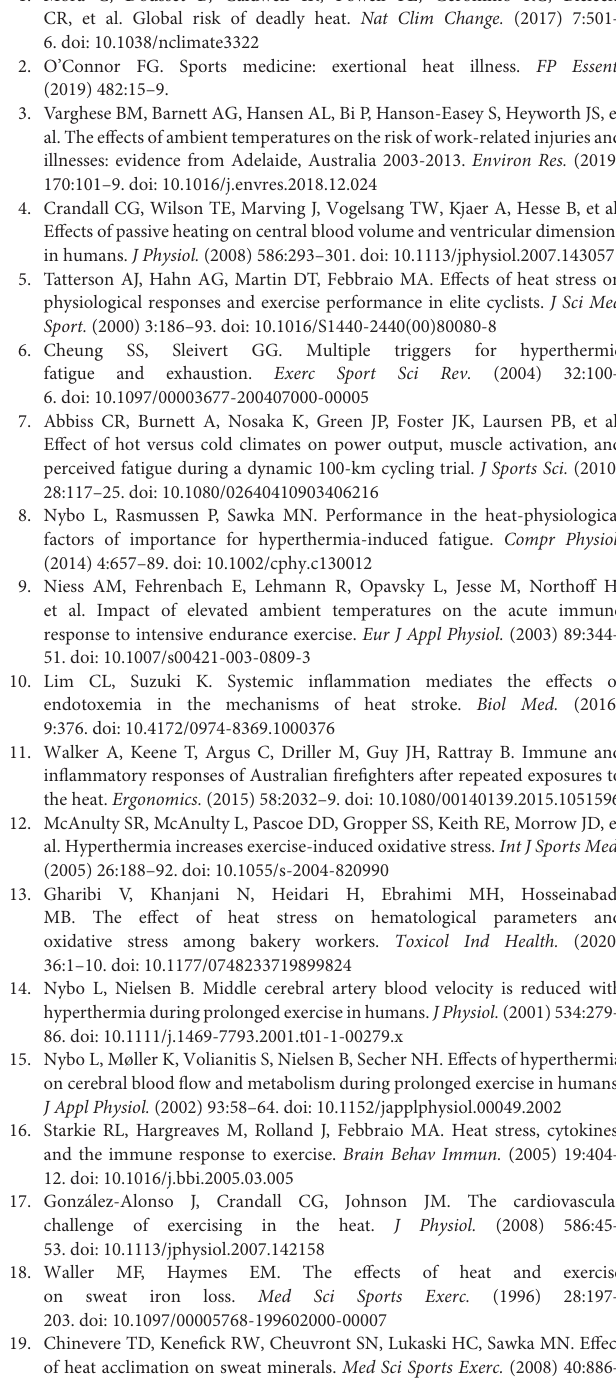
Supplementary Table 1 | Anthropometric characteristics of participants in the single-shot supplement trial at baseline. Data are presented as the means ± SEM. BMI, body mass index.